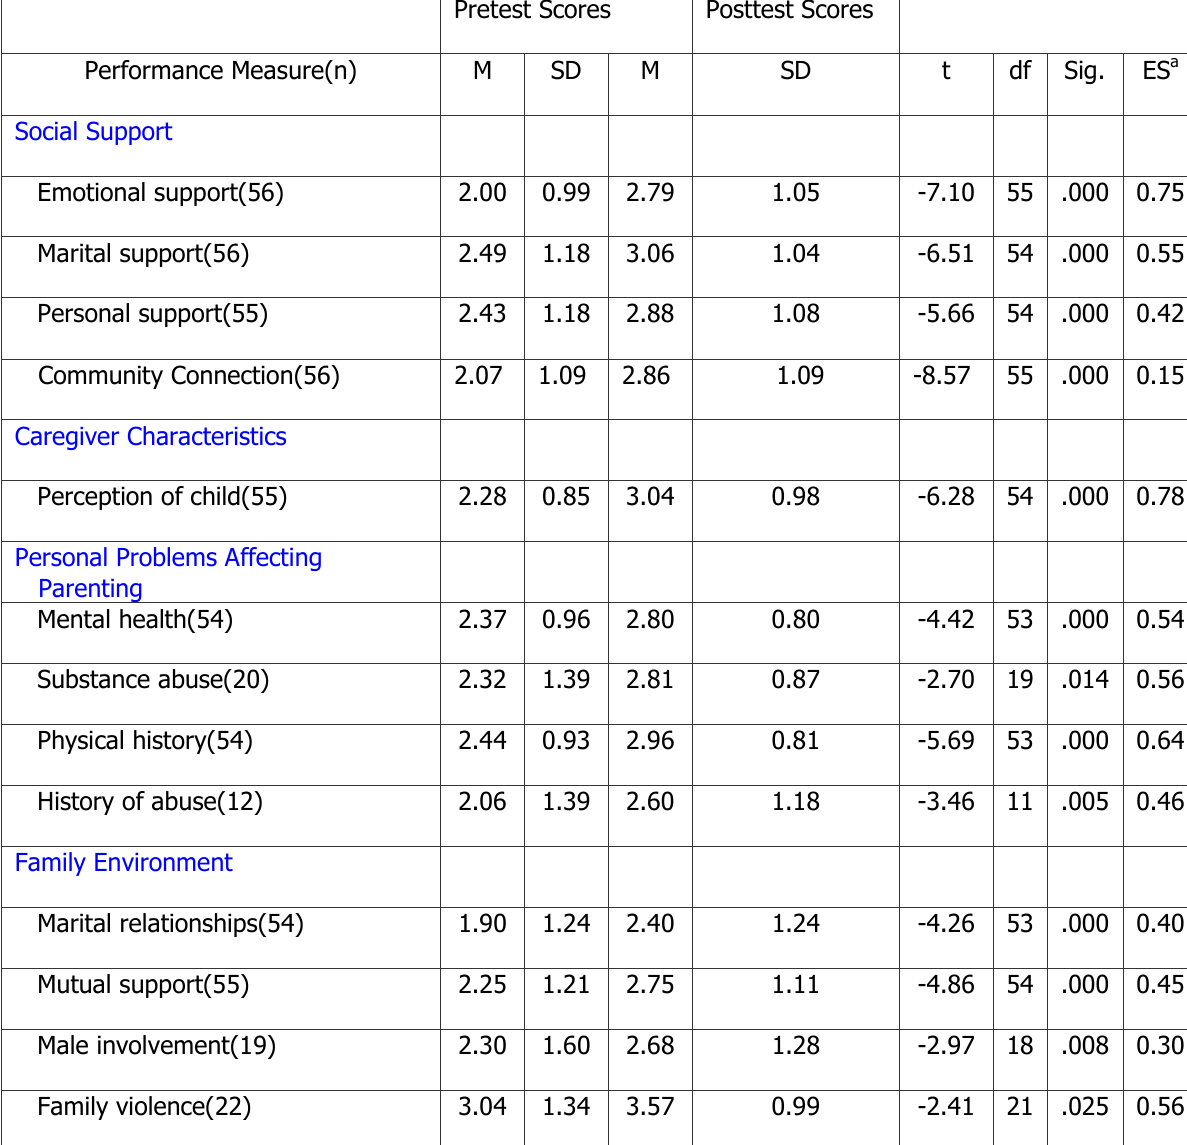
Results of Paired t Test of Outcome Measurements for Prenatal Period Pretest